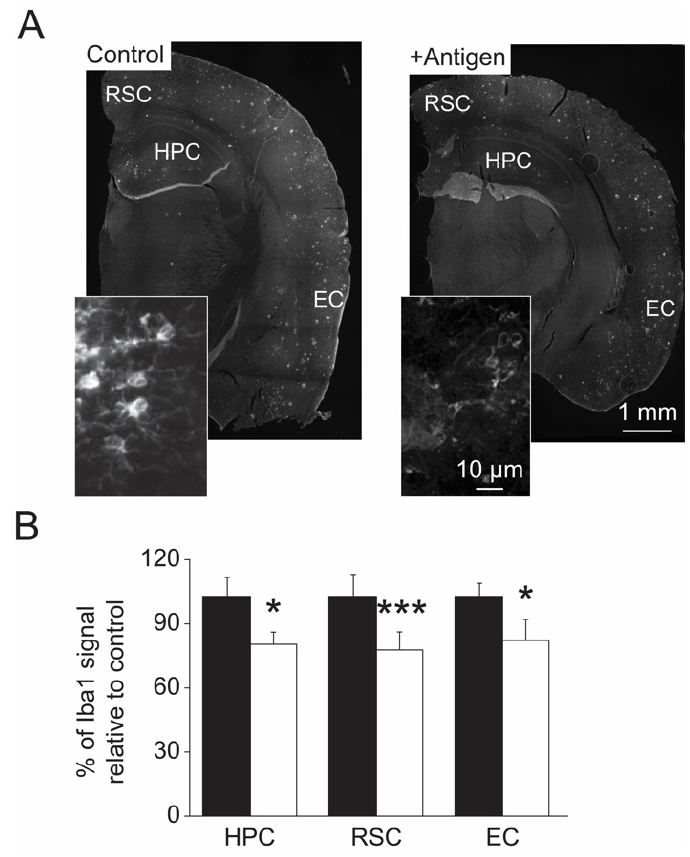
Figure 6. Reduced activation of microglia in antigen-injected mice. ( A ). Hemisphere brains of post- mortem mice (control and antigen-immunized) were dissected, and immunohistochemistry analyses were performed to detect Iba1 according to the procedure described under the Section 2. The data show a decline in the levels of Iba1 of neuronal cells in the three brain regions (HPC, hippocampus; RSC, retrosplenial cortex, and EC, entorhinal cortex) of the antigen-immunized compared with control mice. ( B ). Quantification of the data presented in Panel A using NIH-Image J program. Black and white bars represent control and antigen-injected mice, respectively. Standard deviation is shown for each averaged bar. Data were acquired from five mice per tested group of mice. Statistical analyses were performed using two-tailed student t -test with the following p values: *, p < 0.05; ***, p < 0.001.